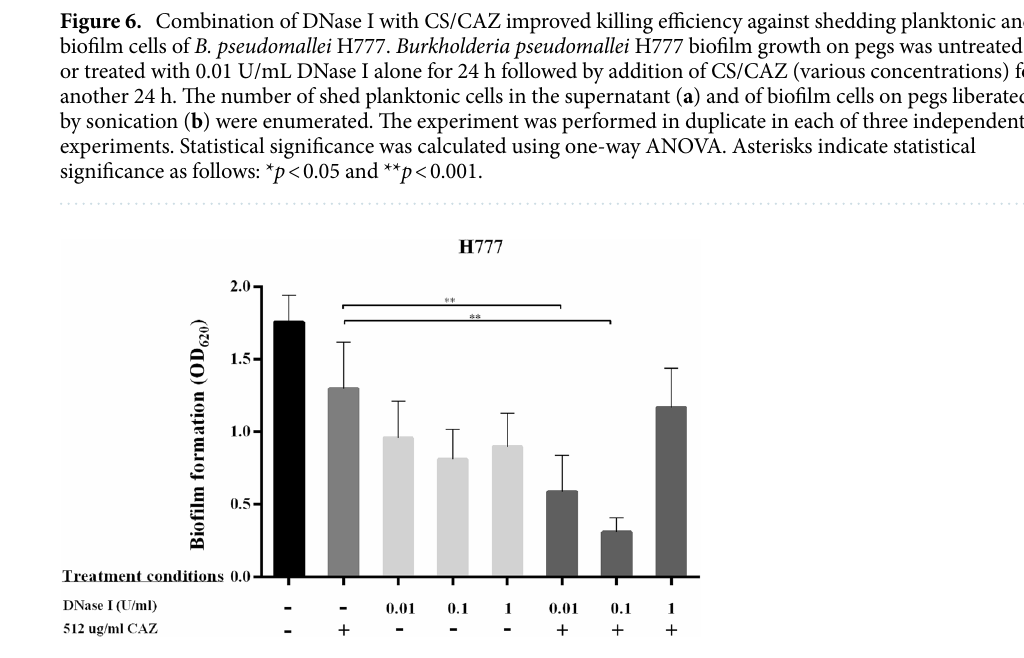
Figure 7. DNase I (0.01 and 0.1 U/mL) combined with CAZ dispersed the B. pseudomallei H777 pre-formed biofilm. The 24 h pre-formed B. pseudomallei H777 biofilm grown on pegs in 96-well plate was treated with 0.01, 0.1, and 1 U/mL DNase I and 512 µg/mL CAZ for another 24 h. The 2-day biofilm was examined using crystal violet staining. The experiment was performed in duplicate in each of three independent experiments. ** p <